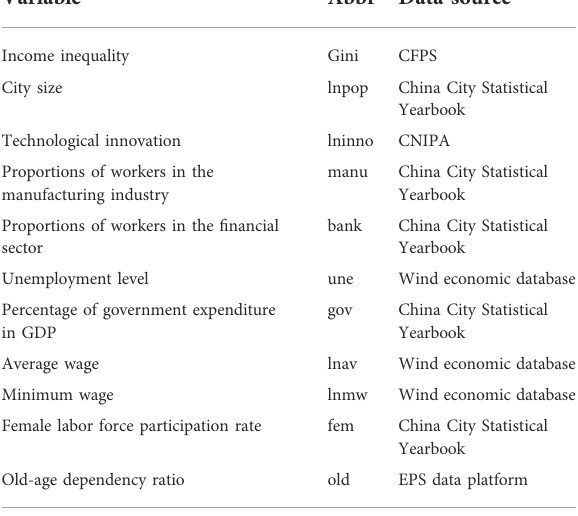
TABLE 1 Variables and data source.